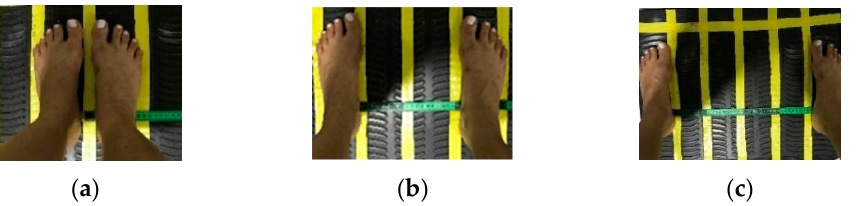
Figure 2. The position of peak-to-peak displacement (PPD) was used and the distance, in cm, between the feet at the base of VP was to ( a ) 2.5 mm of PPD, 3 cm between the feet; ( b ) 5.0 mm of PPD, 21 cm between the feet; and in ( c ) 7.5 mm of PPD, 39 cm between the feet. In the (i) variable frequency group (VFG-WBVE, n = 16) the individual performed 1 min of WBVE (semi squat position) and 1 min of rest in 2.5-, 5.0- and 7.5-mm PPD. This sequence was performed 3 times from the 1st to the 4th session (18 min of total time); 4 times from the 5th to the 8th session (24 min of total time) and 5 times from the 9 to the 12th session (30 min of total time). The frequency increased from 5 to 16 Hz, with an increase of 1 Hz at each session.